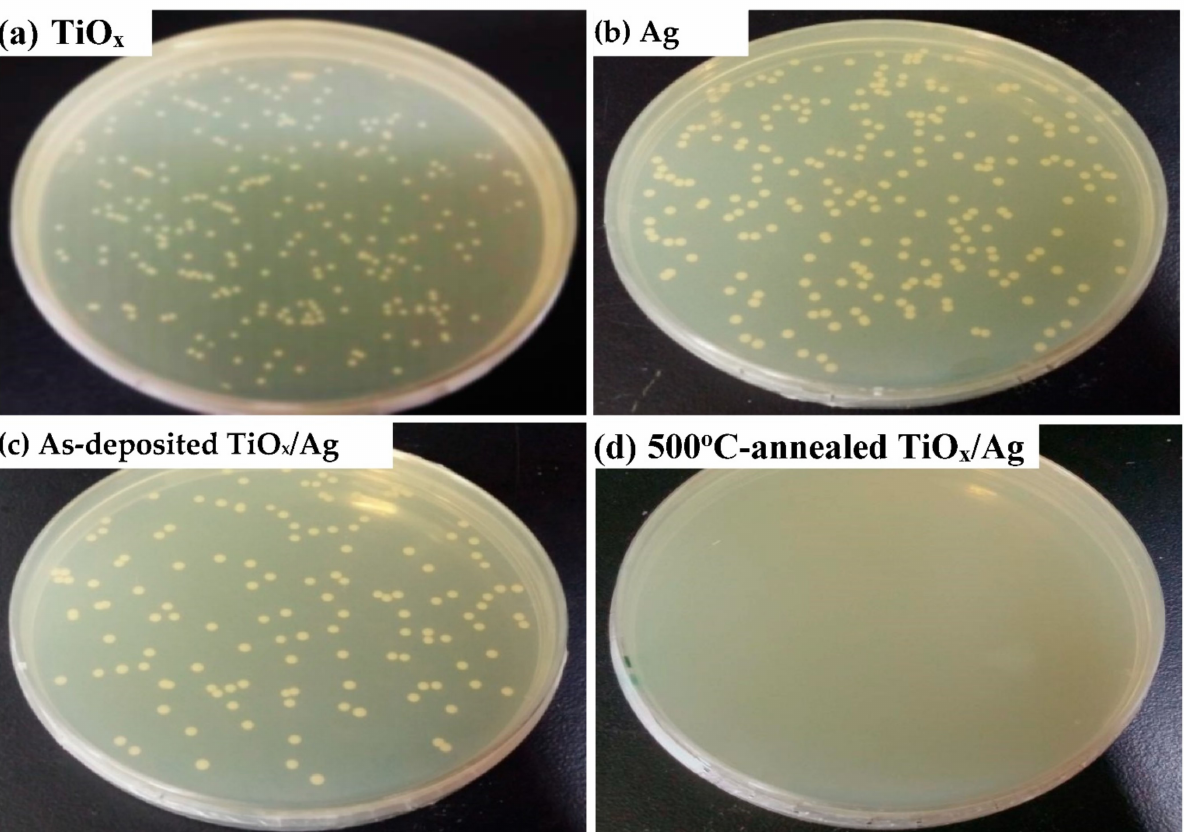
Figure 10. Photographs of the E. coli bacterial colonies on the nutrient agar after a 24 h incubation period that are sterilized using the ( a ) TiO x , ( b ) Ag, ( c ) as-deposited TiO x /Ag and ( d ) annealed TiO x /Ag samples under the UV-lamp irradiation for 1